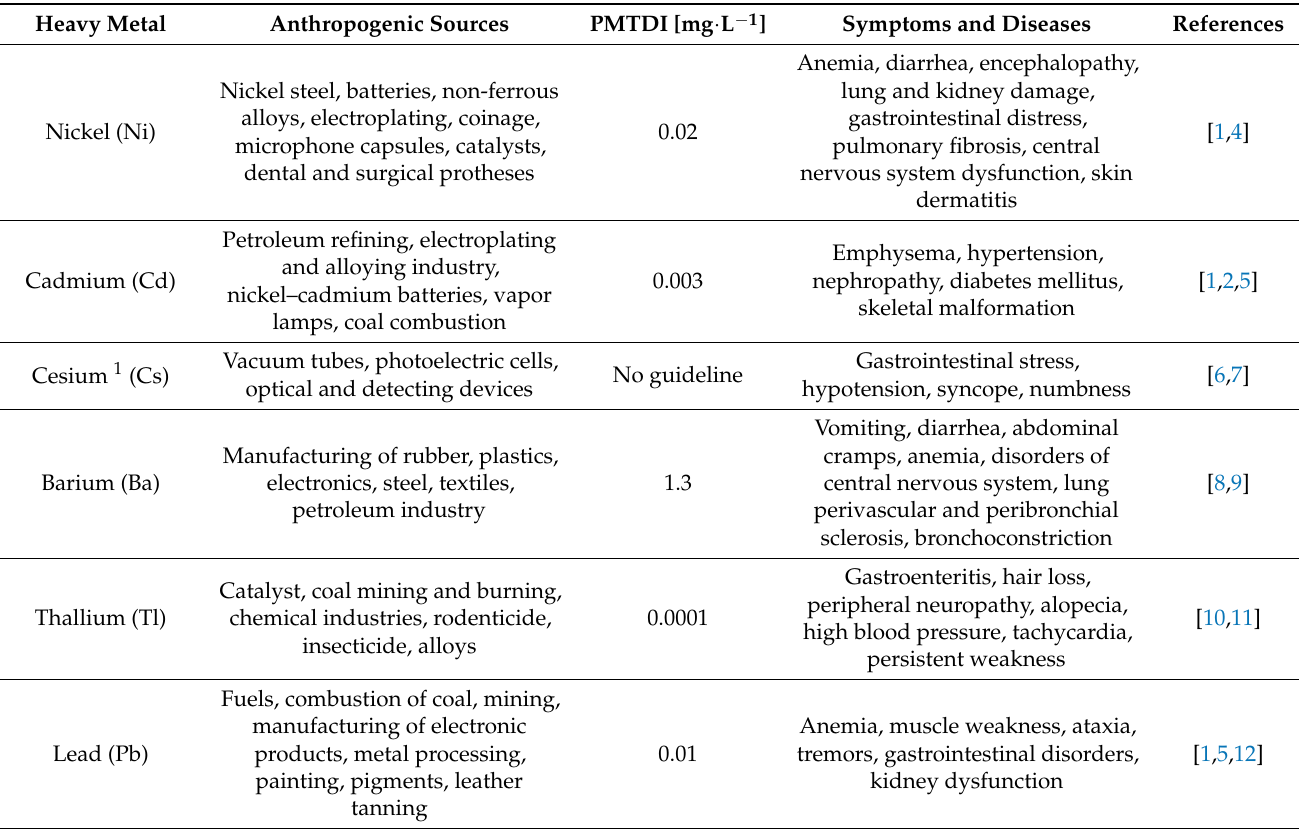
Table 1. Comparison of selected heavy metals, their anthropogenic sources, provisional maximum tolerable daily intake (PMTDI) according to the WHO, and related symptoms and